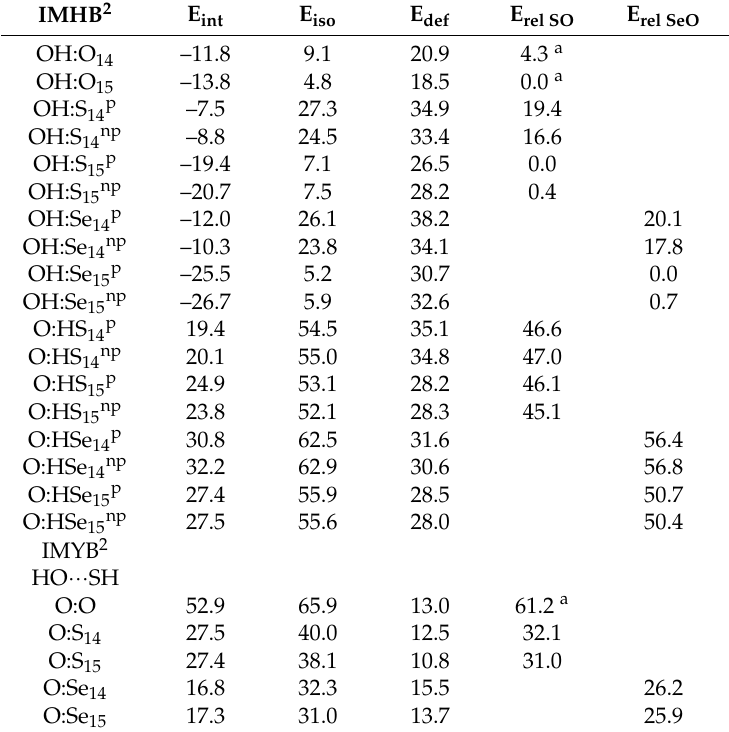
Table 4. Relative, E rel , and interaction energies, E iso , E b , and deformation energies E def , (kJ · mol − 1 ) for the different compounds at MP2/CBS computational level. IMHB 2 E int E iso E def E rel SO E rel